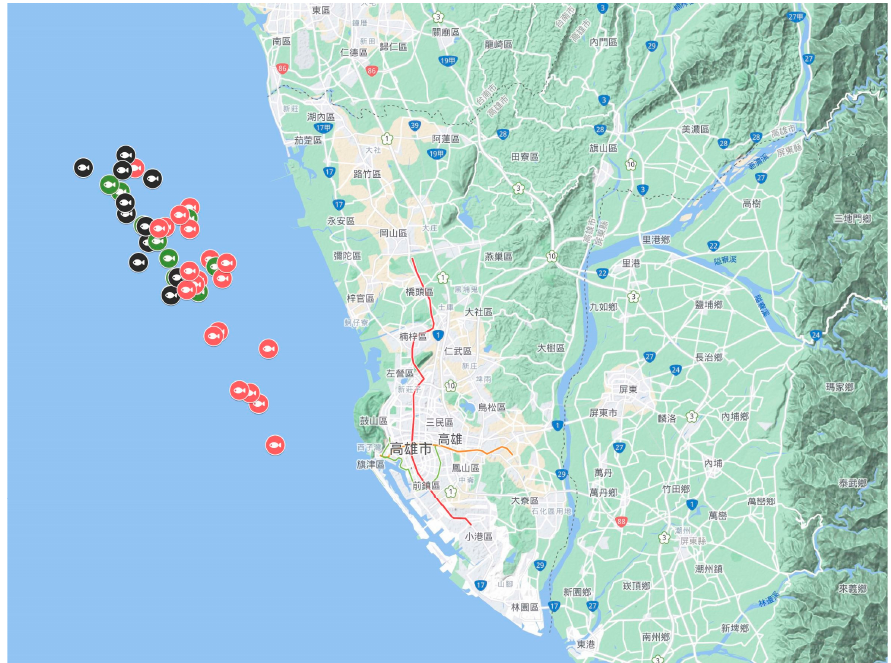
Figure 7. Sea areas of the JTED performance tests. The black, red, and green circles represent sites where JTED (10mm) , JTED (15mm) , and JTED (20mm) were tested, respectively. The trial is located off the coast of Kaohsiung in southwestern Taiwan, 4.3–9.7 nautical miles from the shore. This figure was created using Google Maps.